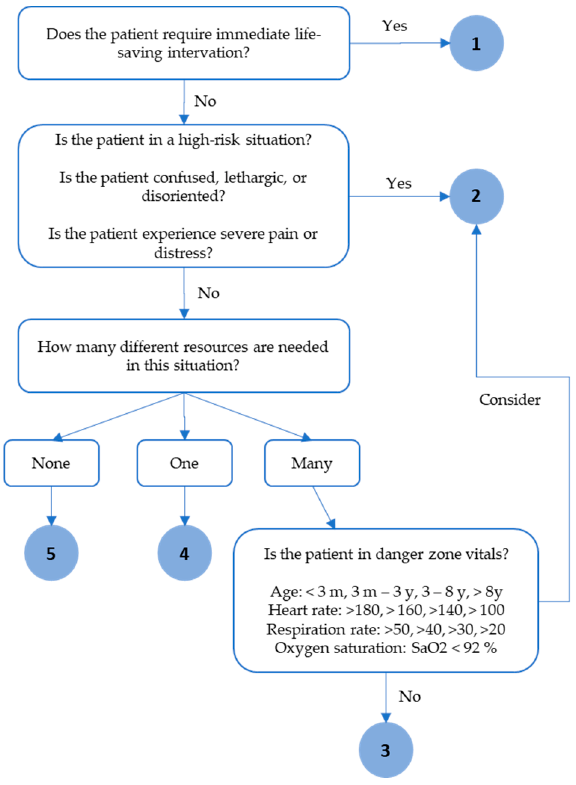
Figure 1. ESI Triage Algorithm (Gilboy et al., 2005).